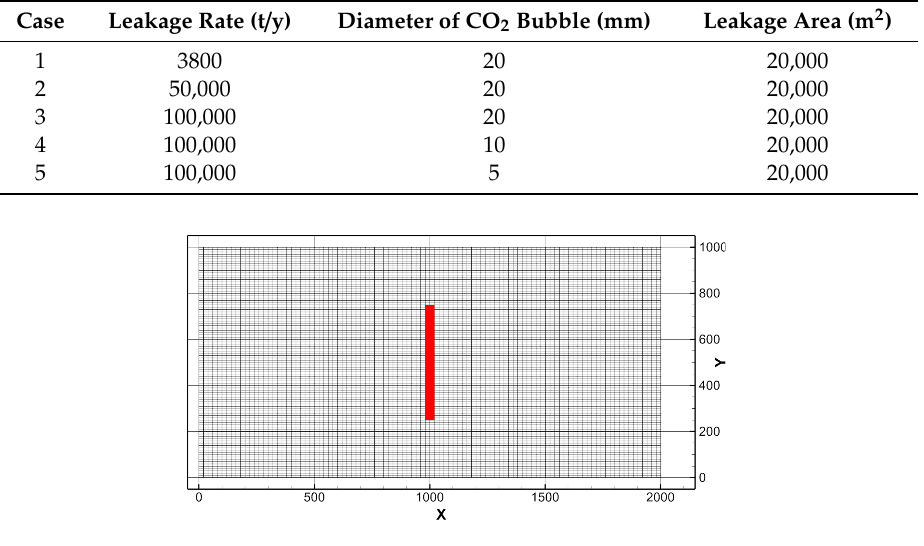
30 days Figure 6. Velocity vector fields on the horizontal planes (upper rows: near free surface, lower rows: z = –187 m) at 28, 29, and 30 days after the start of simulation (data are skipped by 2). 4.1. Effect of Leakage Rate (Cases 1, 2, and 3/Bubble Size = 20 mm, Leakage Area = 20,000 m) Figure 7 shows contour maps of some variables on the center plane in the x direction (x = 1000 m) of the small-scale domain, 30 days after the start of leakage. From the distribution of void rate and cell-averaged number densities of CO 2 bubbles, it can be seen that all CO 2 bubbles leaking from the depth of 190 m would be dissolved at a depth of 70 m before reaching the free surface. Because the initial diameter of the CO 2 bubbles are the same, but the leakage rates are different for these cases, the void rates of the bubbles near the leakage depth are higher than other depths and become lower as the depth becomes shallower due to the rising and dissolution of the bubbles to the surrounding seawater. The reason for the higher values of the number densities near the depth of 100 m is that the density of the bubbles is almost the same as that of seawater, and the volume of the bubbles is very small, which makes the buoyant force zero. Although the velocity vector fields or contour maps of the velocities are not presented, one may know that complex flows exist owing to the rising of the CO 2 bubbles with surrounding seawater and tidal flows from the distribution of the DCO 2 shown in Figure 7c. Since more bubbles exist and dissolution lasts for a longer time as the leakage rate increases, relatively higher values and wider areas of dispersed DCO 2 are observed, as shown in the figure. Comparing the contour maps of DCO 2 with those of the changes in DCO 2 (ΔDCO 2 ) due to the dissolution of the bubbles, no large discrepancy is observed because the background DCO 2 is much smaller.